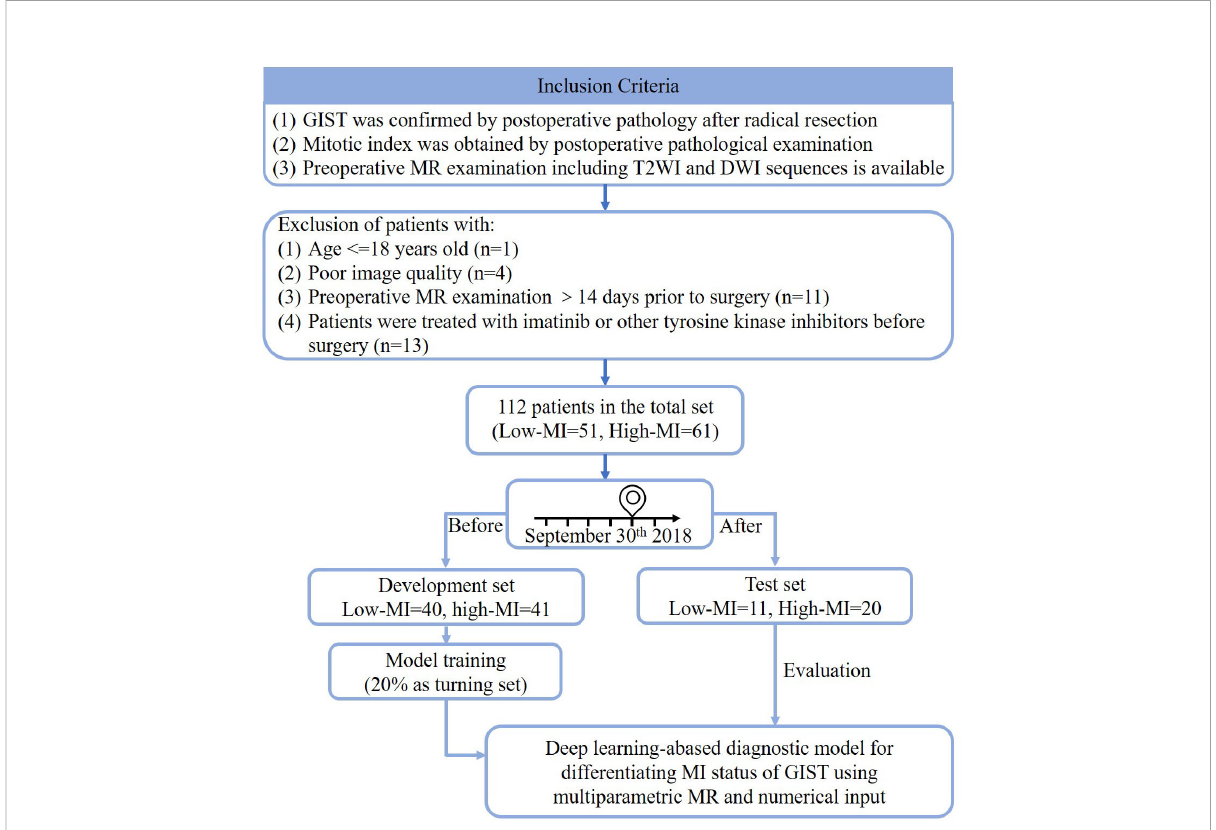
FIGURE 1 The fl owchart of dataset setup. Low-MI, low mitotic index; High-MI, high mitotic